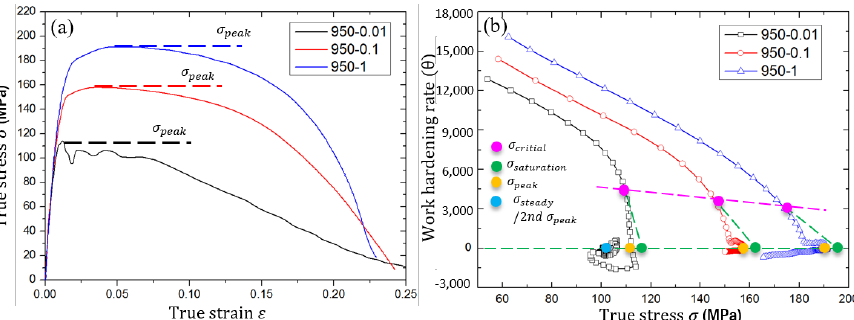
Figure 5. ( a ) Stress–strain curves of 2205 / AH36 BC, and ( b ) relationship curves of work hardening rate versus flow stress at the range of 0.01 s –1 – 1 s –1 with the temperature of 950 ℃ .